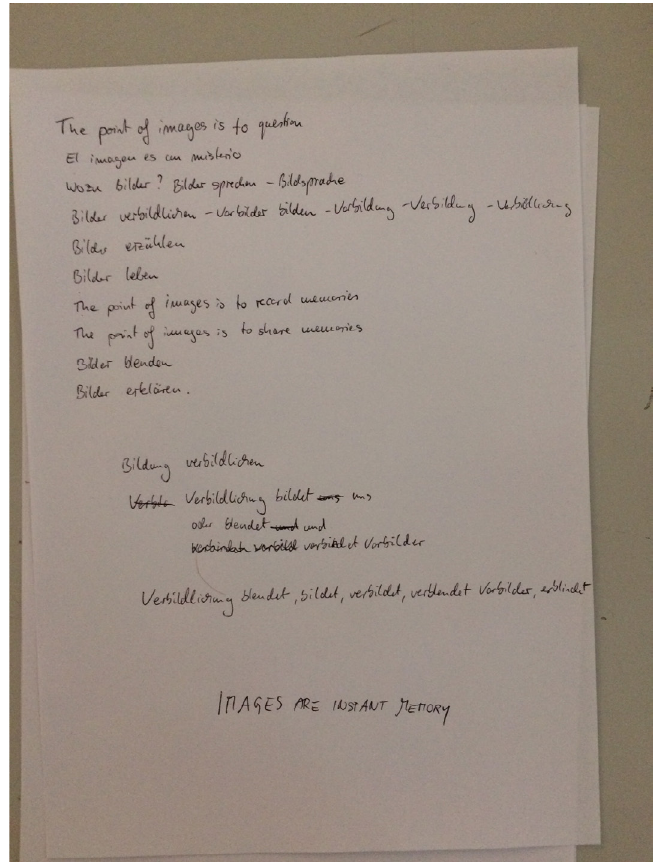
Figure 1. First stage: brainstorming